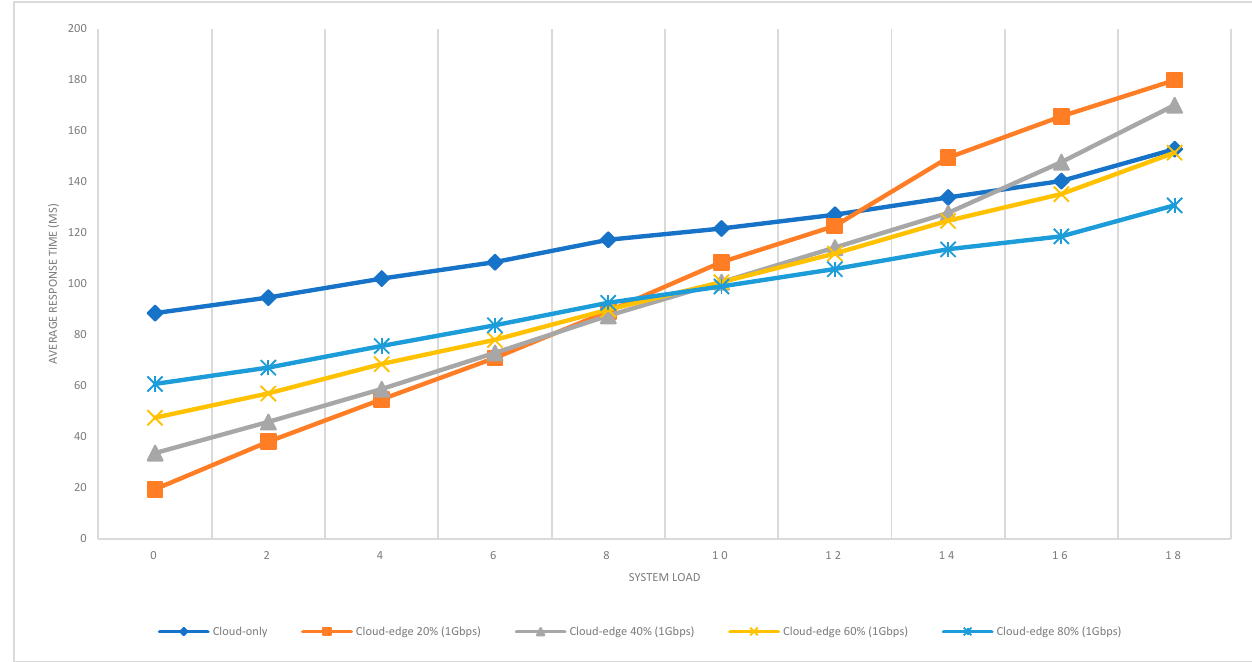
Figure 13. Average response time for a cloud–edge system with different load and resource distri- bution.